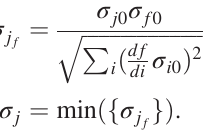
maximum energy target is raised from 150 MeV to TABLE III. Error ranges where all objectives, f ð j Þ , are within